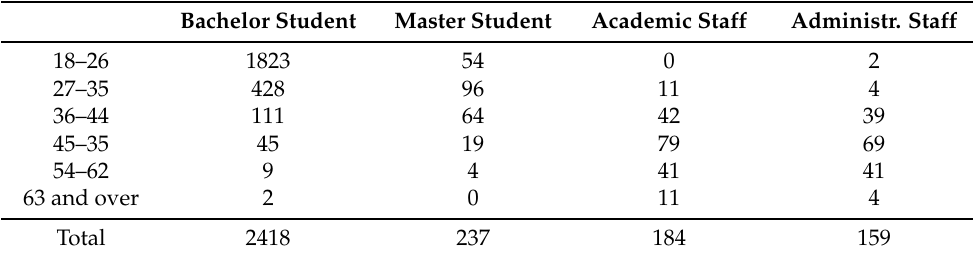
Table 3. Age of respondents grouped by